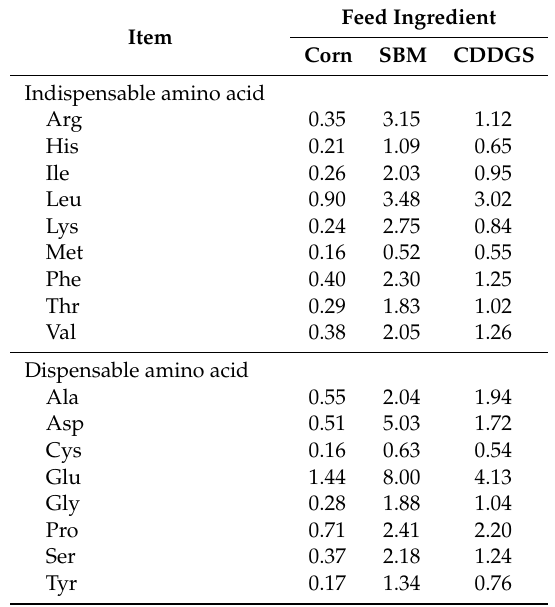
Table 1. Analyzed amino acid composition of feed ingredients (%, as-fed